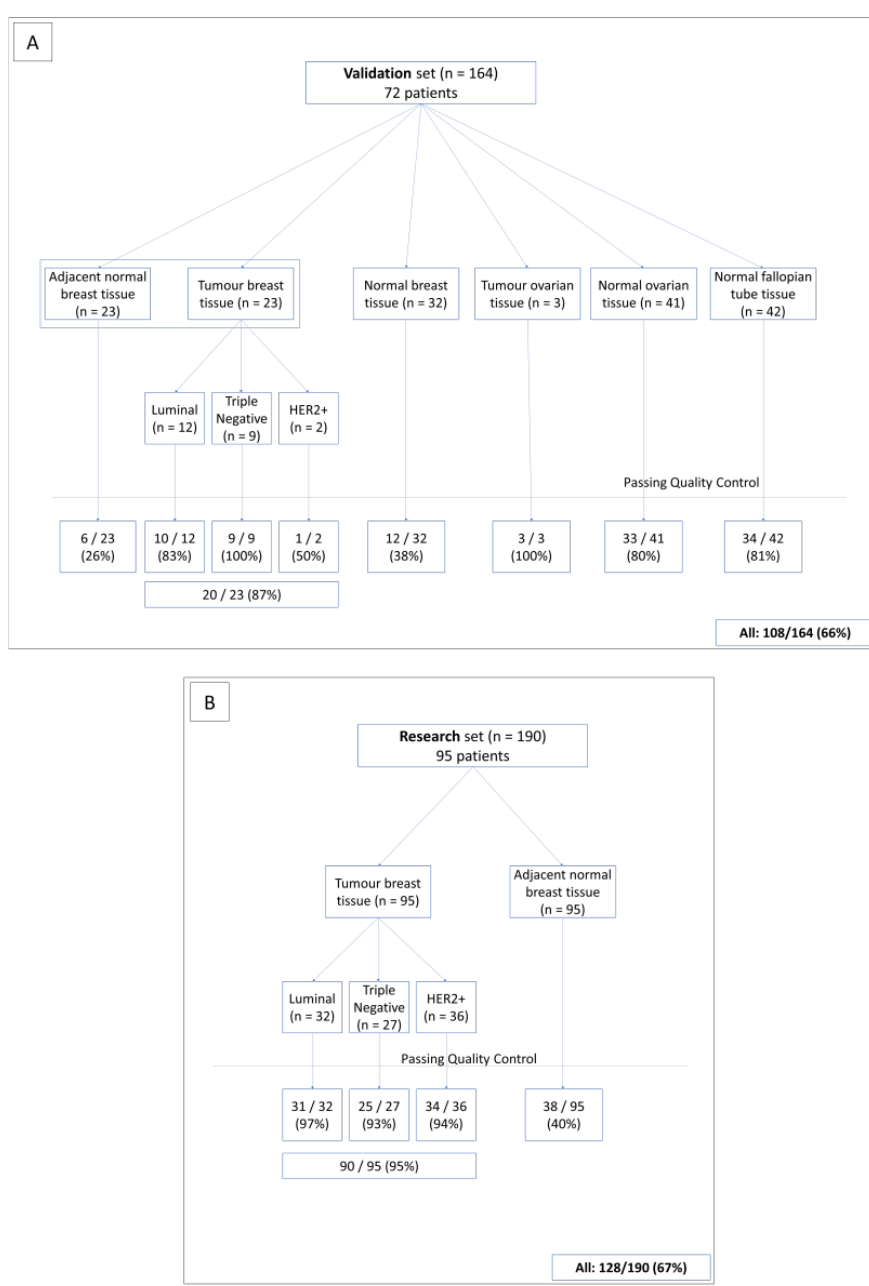
Figure 1. Description of the validation set ( A ) and the research set ( B ). The quality control corresponds to the number of UMI above 1500 for a given